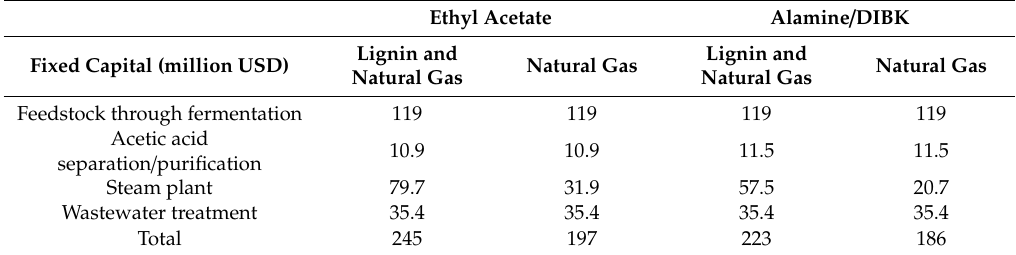
Ethyl Acetate Alamine / DIBK Lignin and Lignin and Natural Gas Natural Gas Natural Gas Natural Gas